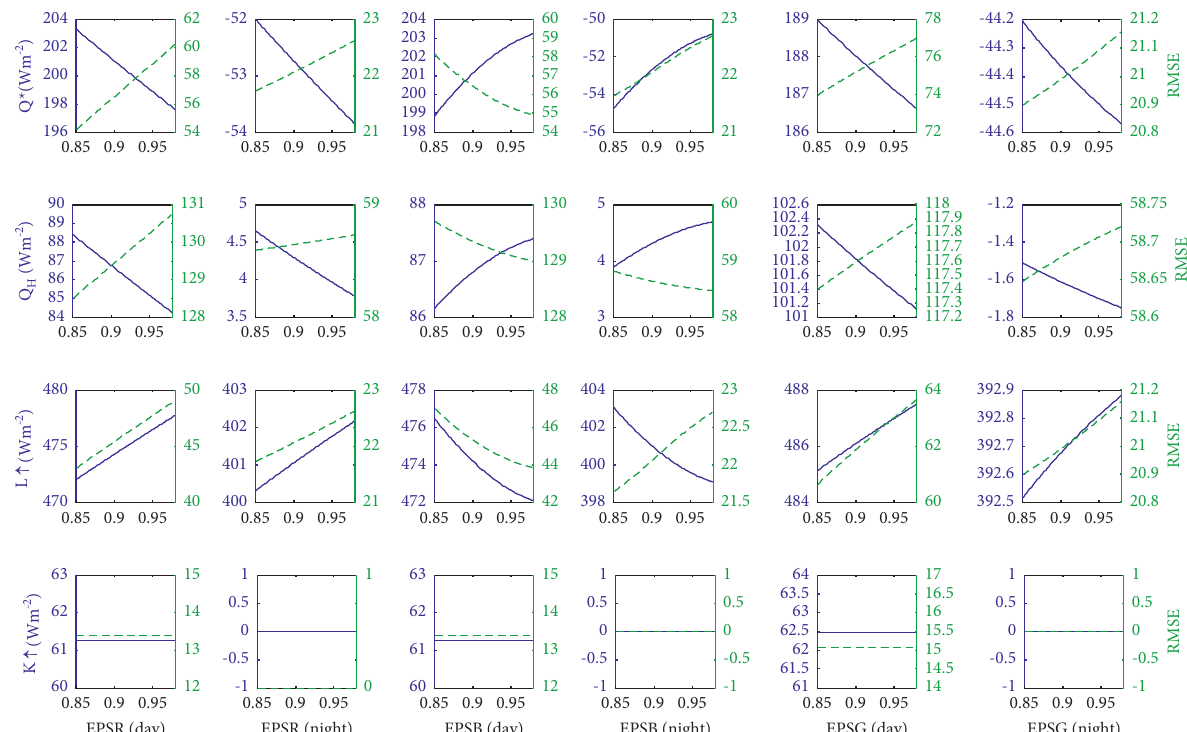
Figure 8: The same as Figure 7, but for roof (EPSR), wall (EPSB), and road (EPSG) emissivity parameters.